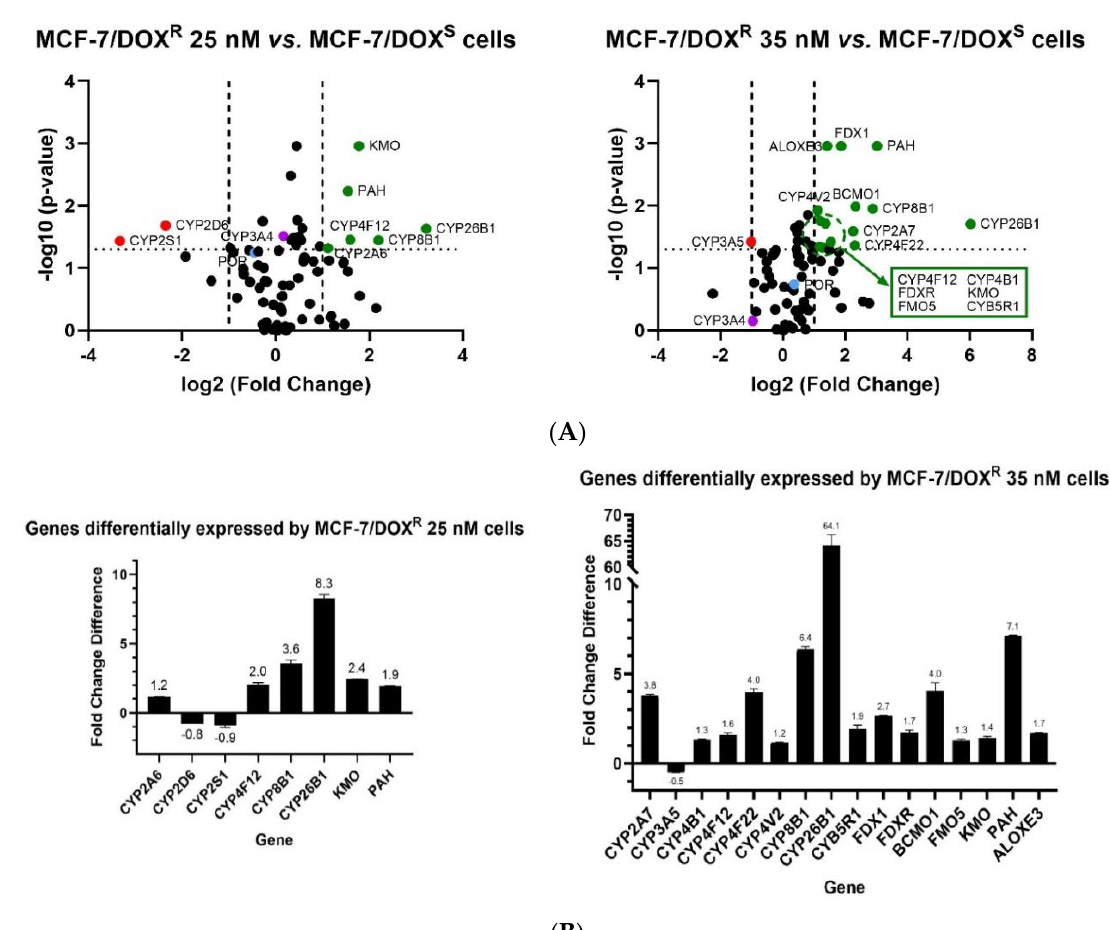
Figure 1. Differences of mRNA levels of target genes in MCF-7/DOX R cells. ( A ) Volcano plots representing the differences in fold change of genes differentially expressed by MCF-7/DOX R 25nM or 35nM cells, relative to the parental MCF-7/DOX S cells. Transcripts levels were considered differentially expressed when p < 0.05 and fold change > 2 (upregulated, in green) or <2 (downregulated, in red). POR (CPR gene) and CYP3A4 transcript levels are depicted in blue and purple, respectively. ( B ) Histograms representing the statistically significant increase (fold change) of target-gene expressions in MCF-7/DOX R 25 nM or 35 nM relative to the MCF-7/DOX S cells (technical replicates, N = 2). ALOXE 3: arachidonate lipoxygenase 3; BCMO1: β - carotene 15,15’ -monooxygenase 1; CYB5R1: